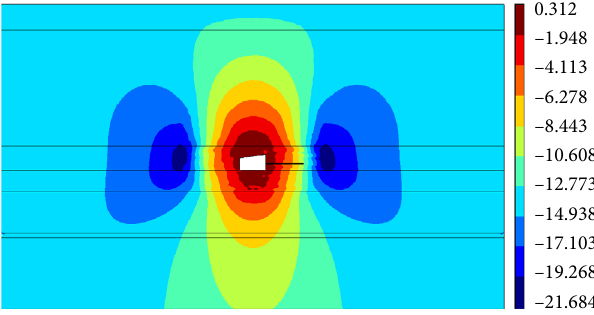
Figure 9: Vertical stress variation law of surrounding rock beside roadway.